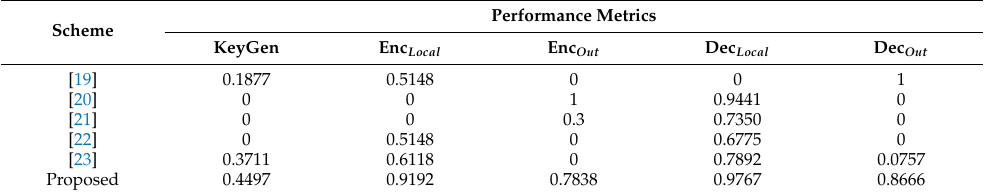
Table 6. Analysis results of